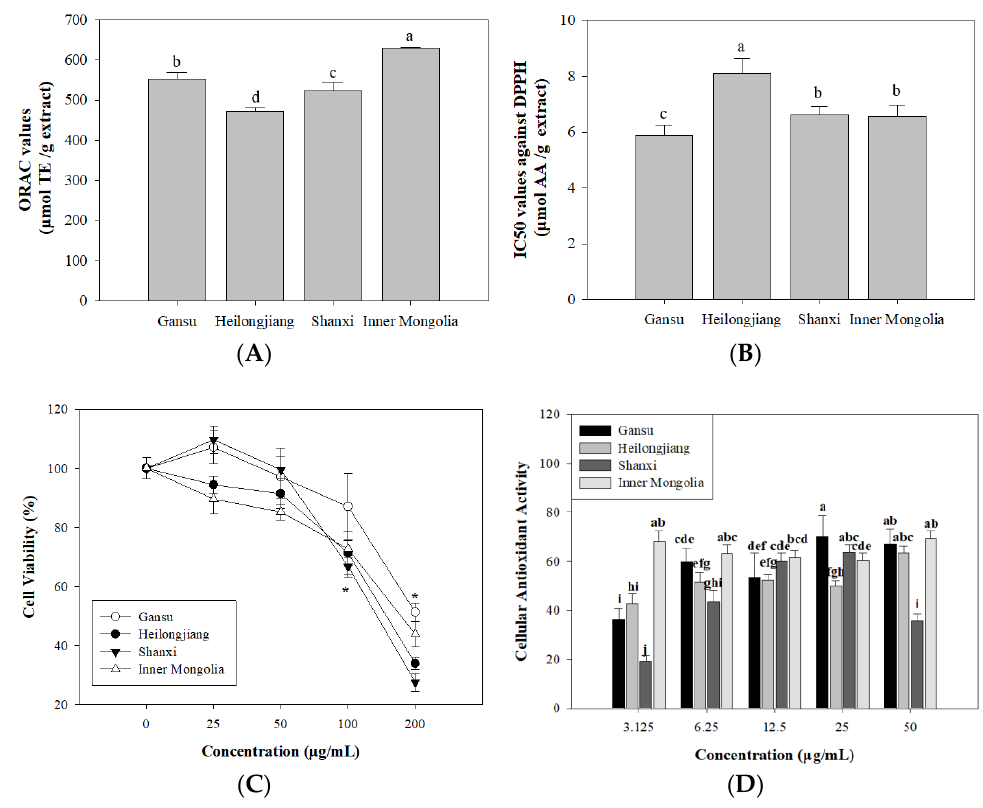
Figure 4. Antioxidant activities of Astragalus extracts from different origins. ( A ), ORAC value; ( B ), DPPH radical scavenging activity; ( C ), Cytotoxicity; ( D ), Cellular antioxidant activity. Different letters indicate values have significant differences ( p <